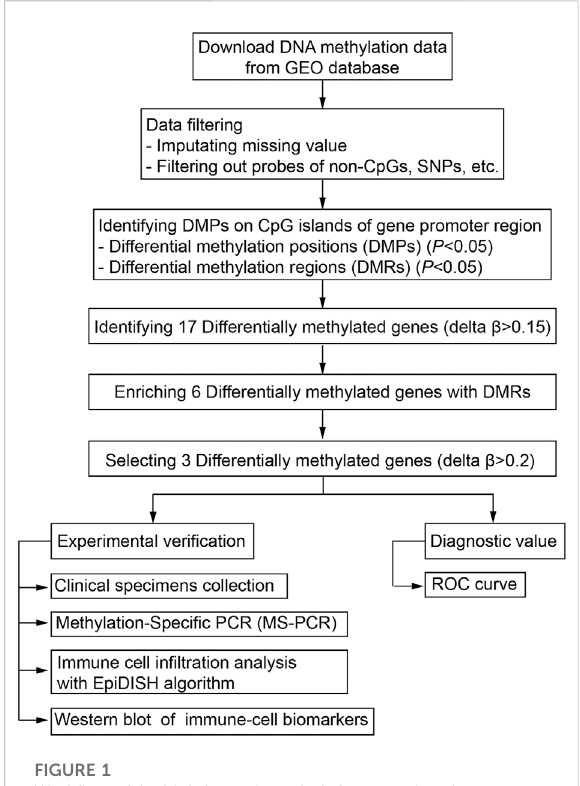
FIGURE 1 Work fl owofthebioinformaticanalysisforscreeningaberrant DNA methylation